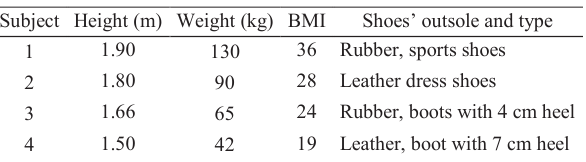
Table 1. Data from the measured subjects. BMI is the body mass index (kg/m 2 ).